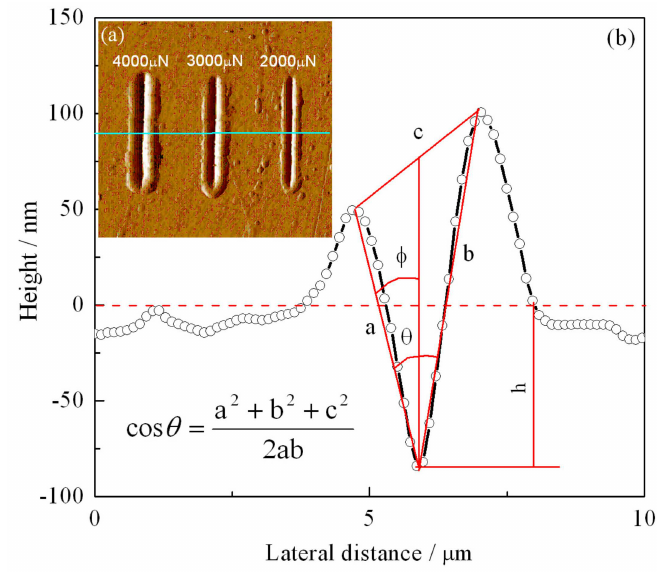
Figure 11. ( a ) Nano-scratch of scanning probe topography and ( b ) cross-section of the scratch depth of 600 ◦ C-tempered, cumulative proton irradiation flux 2 × 10 15 p / cm 2 AISI 420 steel under a 4000 µ N normal load condition.